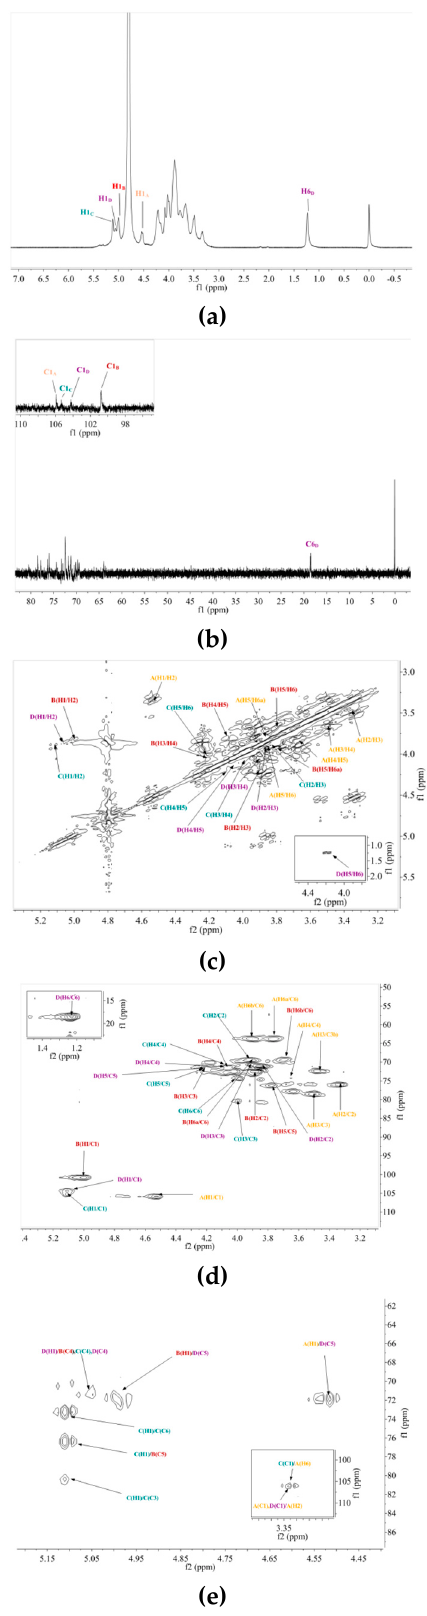
Figure 5. 1 H spectrum ( a ); 13 C spectrum ( b ); COSY spectrum ( c ); HSQC spectrum ( d ); HMBC spectrum ( e ).